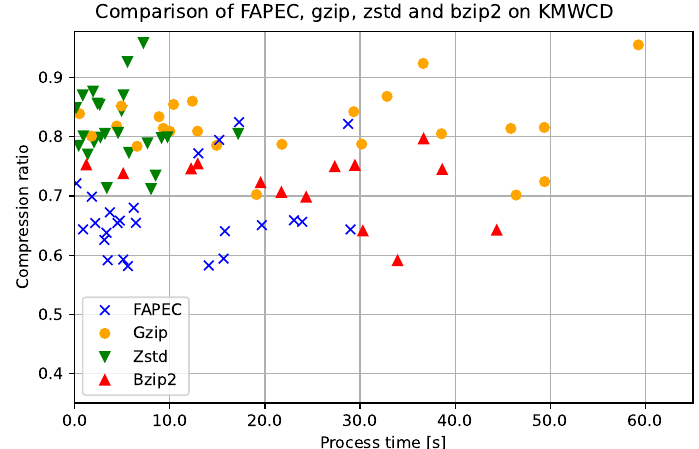
Figure 10. Comparison of time and ratio performance of lossless compressors for KMWCD files.